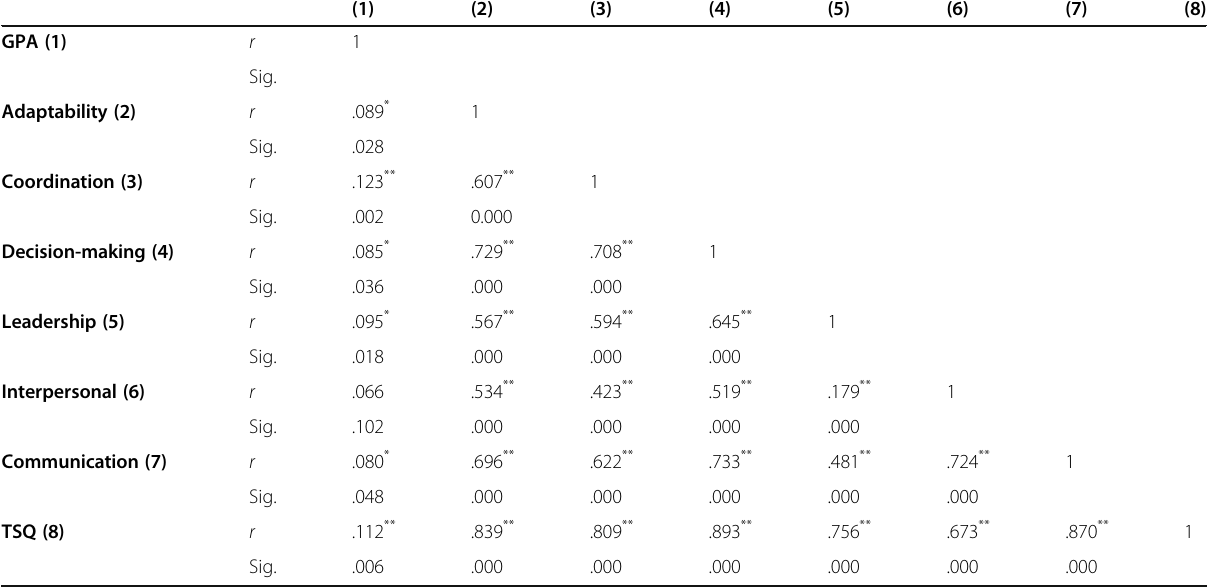
Table 5 Correlations between each of the factors, overall and GPA